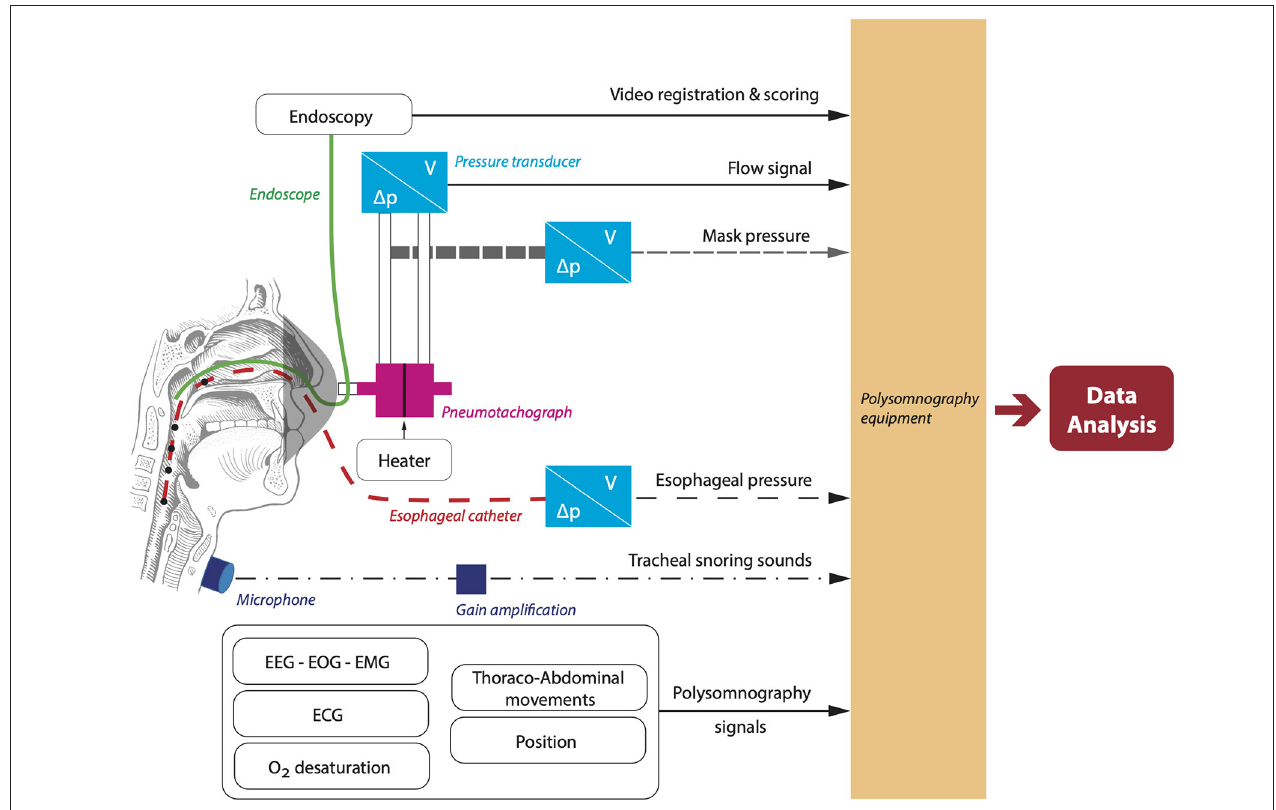
FIGURE 3 | Overview of the set-up to simultaneously measure airflow and capture endoscopy footage. ECG, electrocardiography; EEG, electroencephalography; EMG, electromyography; EOG,